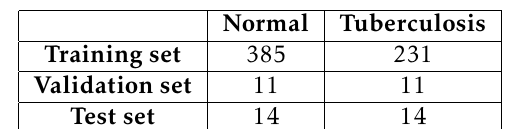
Table 3. Details about how Montgomery dataset is splitted and